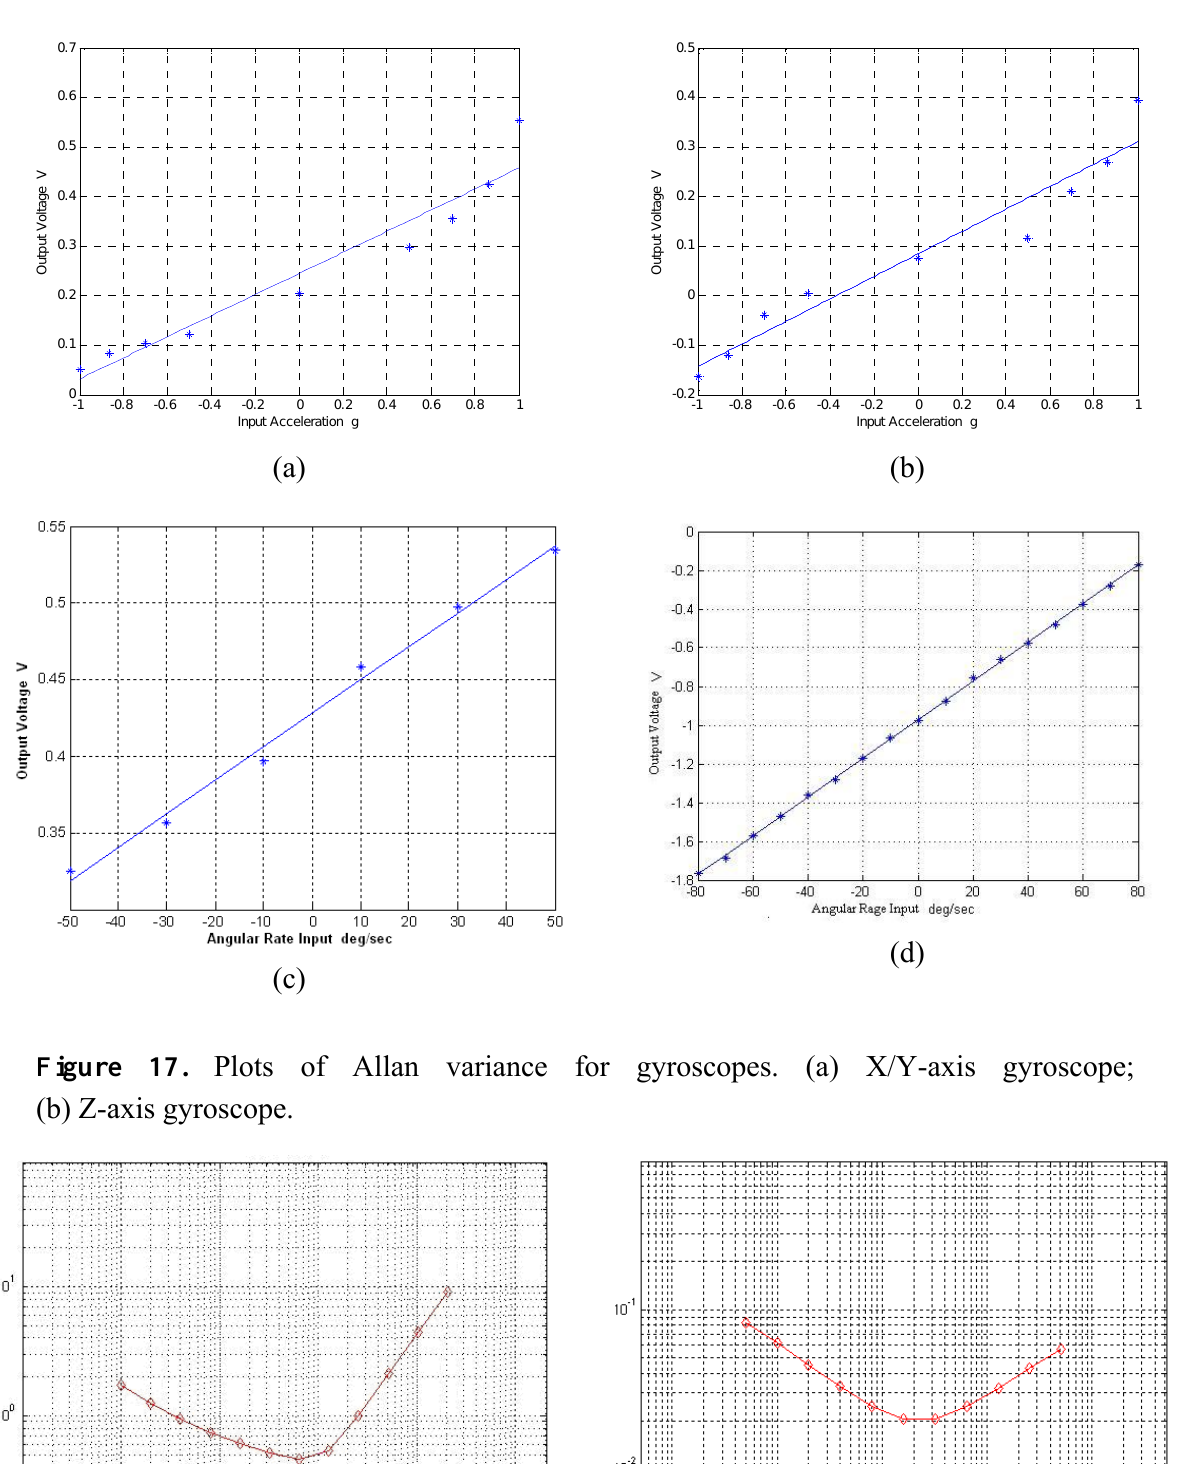
Figure 16. Scale factors for the six sensors in the MIMU. (a) X/Y-axis accelerometer; (b) Z-axis accelerometer; (c) X/Y-axis gyroscope; (d) Z-axis gyroscope.